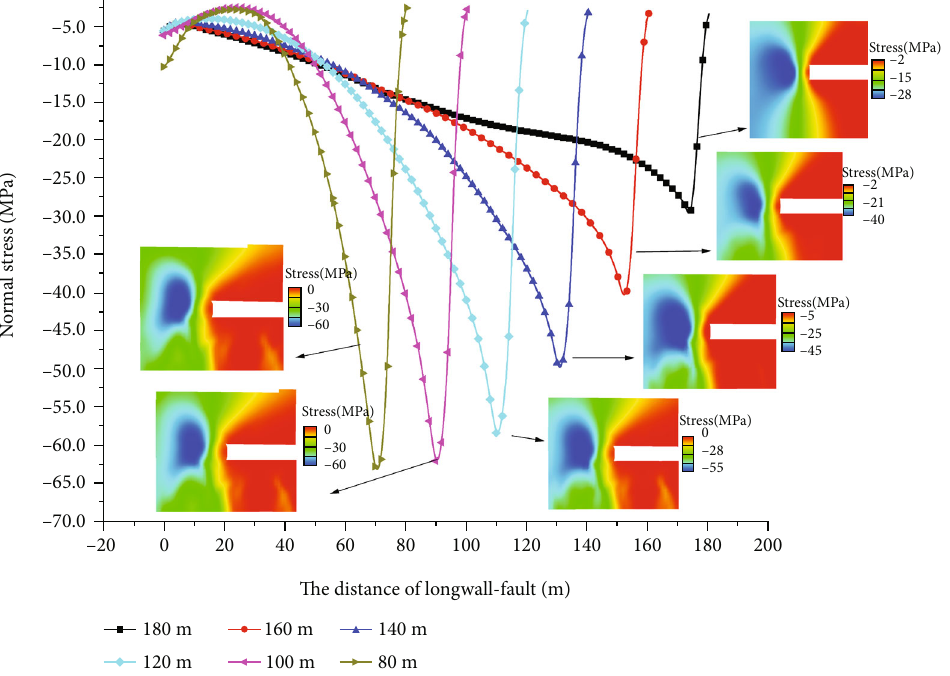
Figure 5: Stress and nephogram of the coal seam in excavation stage 1 of the longwall